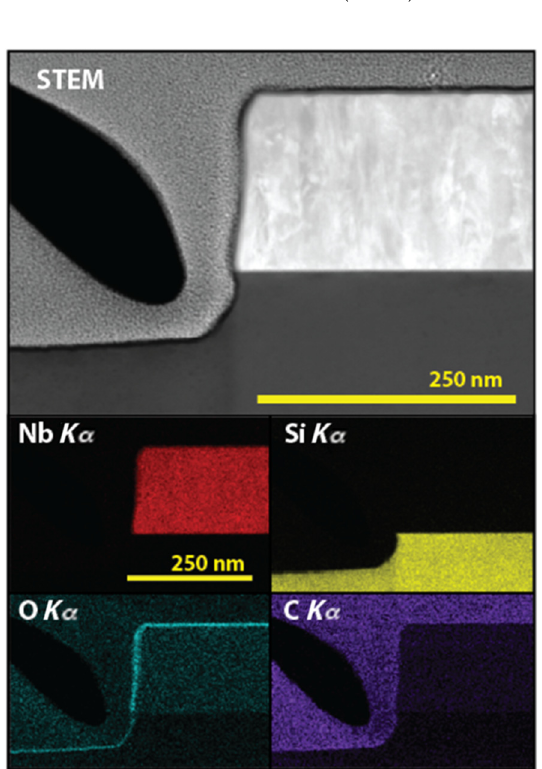
FIG. 17. The evolution of the niobium (MA) interface oxide with the BOE etch time. The NbO x layer thickness is steadily